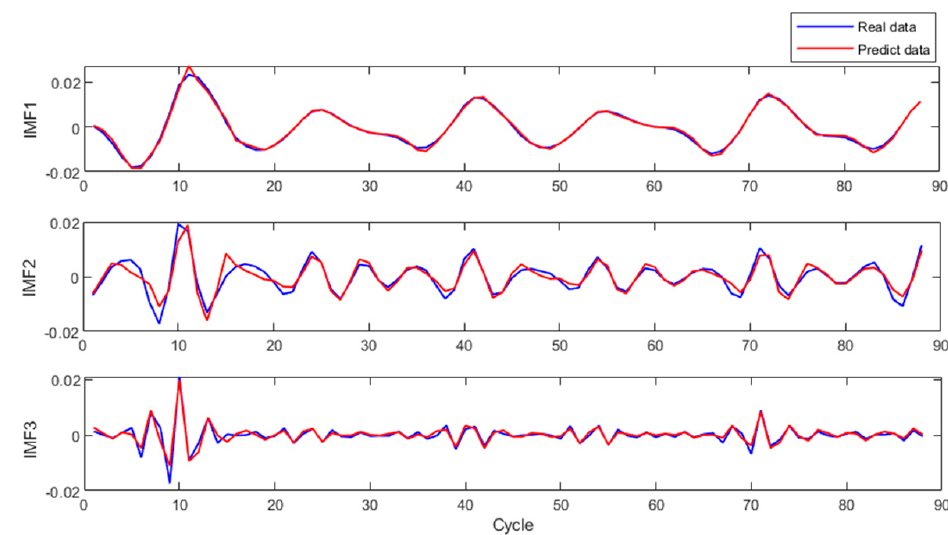
Figure 6. Prediction results of the B0005 battery capacity recovery components. The residual component predicted by LSTM and the capacity recovery components predicted by the GPR model are added according to Formula (7) to obtain the predicted lithium-ion battery capacity. As shown in Figure 7, the predicted battery capacity curve is very close to the actual battery capacity curve. The battery capacity recovery and random fluctuation phenomena are well captured, indicating that the improved VMD-LSTM-GPR method can achieve accurate prediction of the RUL of lithium-ion batteries.